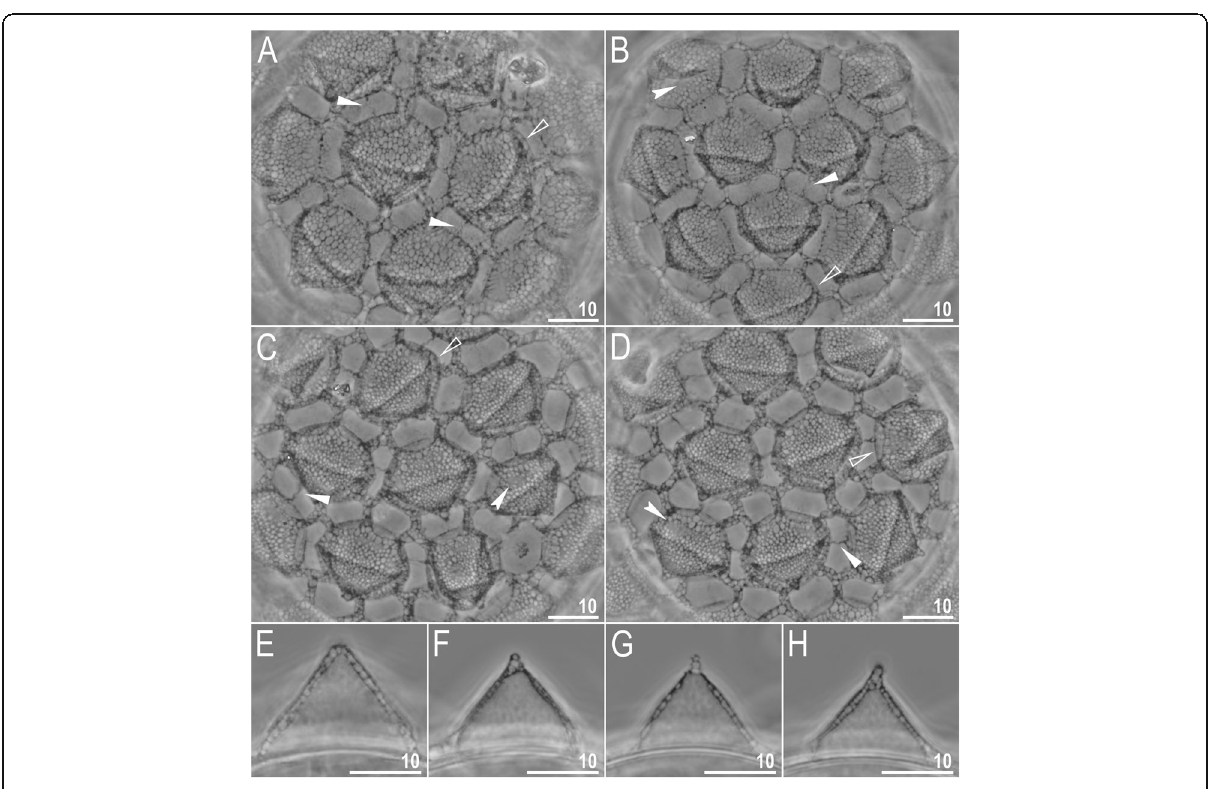
Fig. 9 Macrobiotus pallarii Maucci, 1954 from the topotypic population (IT.337) – eggs seen with LCM: a – d – surface under ×1000 magnification of four different eggs; e – h – midsections of four different egg processes. Filled flat arrowheads indicate thickening perpendicular to the process base that divides the areola in the middle, filled indented arrowheads indicate areas of the egg processes without a reticulation/labyrinthine layer, and empty flat arrowheads indicate irregular collar around process bases. Scale bars in μ